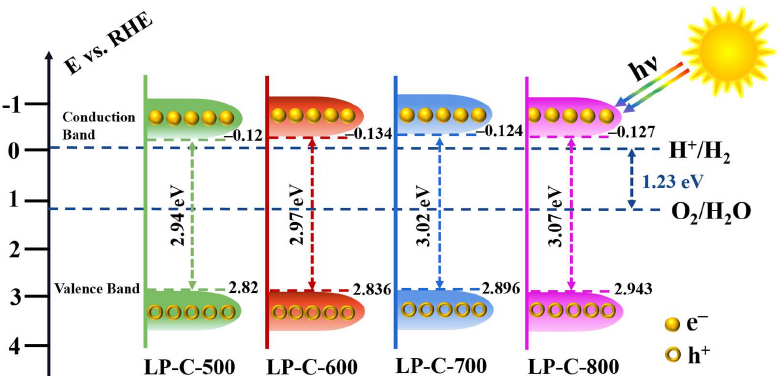
Figure 10. Proposed band structure of pollen carbon and redox potentials of water splitting.